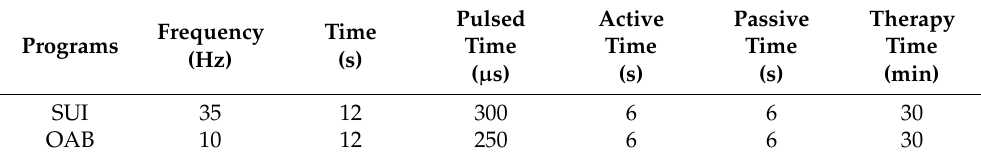
Table 1. FMS Tesla Care ® chair program for different type of